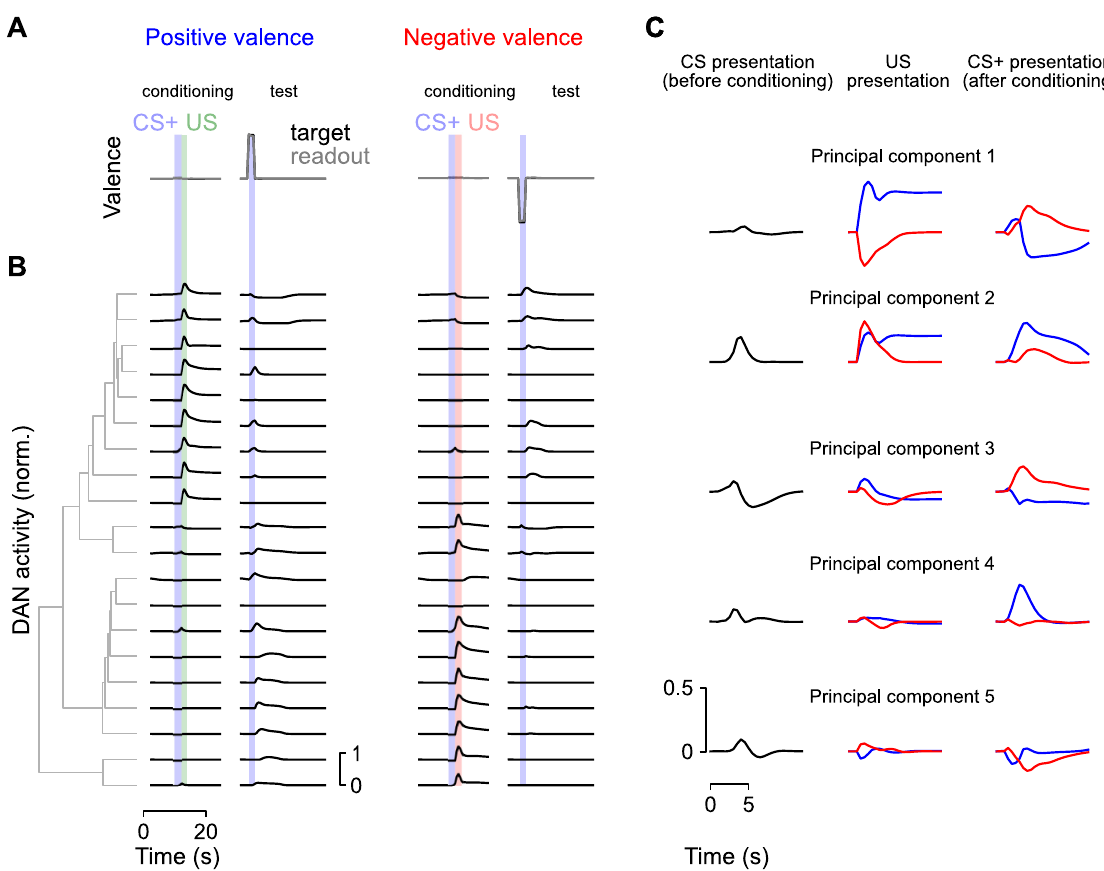
Fig 5. Population analysis of dopamine neuron (DAN) activity. (A) First-order conditioning trials with positive or negative valence US. (B) Responses of model dopamine neurons from a single network. Neurons are sorted according to hierarchical clustering (illustrated with gray dendrogram) of their responses. (C) Principal components analysis of dopamine neuron population activity. Left: Response to CS before conditioning. Middle: Response to a positive (green) or negative (red) valence US. Right: Response to a previously conditioned CS.